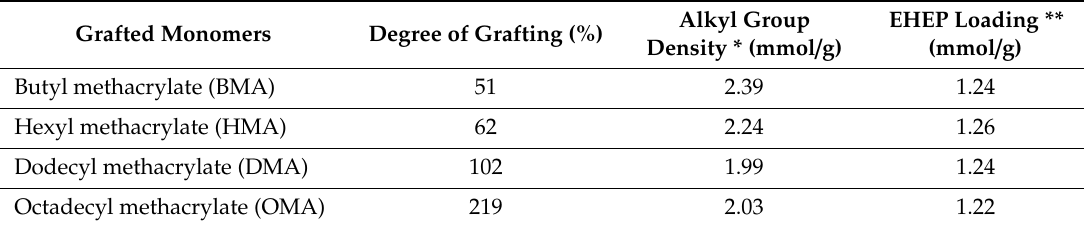
Table 2. Degree of grafting and alkyl group density of the grafted fabrics, and the EHEP loading of the corresponding